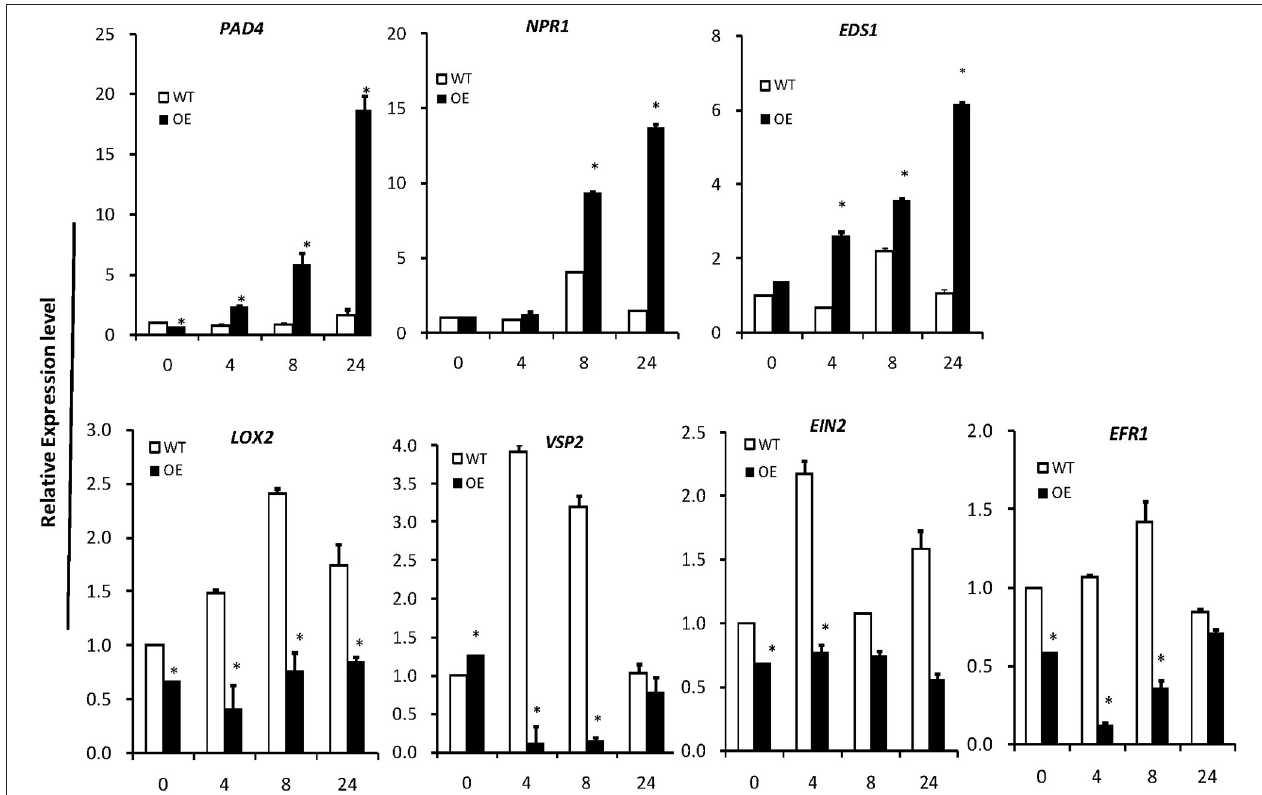
FIGURE 9 | Expression patterns of plant defense-response genes. PAD4 , EDS1 , SA synthesis-related genes NPR1 is a key regulator of SA-dependent systemic acquired resistance. LOX2 and VSP2 are the JA synthesis-related genes. EIN2 and EFR1 is the ethylene signaling pathway receptor gene. AtActin8 was used as reference control. In all panels, the mean is based on the average of three independent experiments. One-way ANOVA was used to generate the P -values (* P <